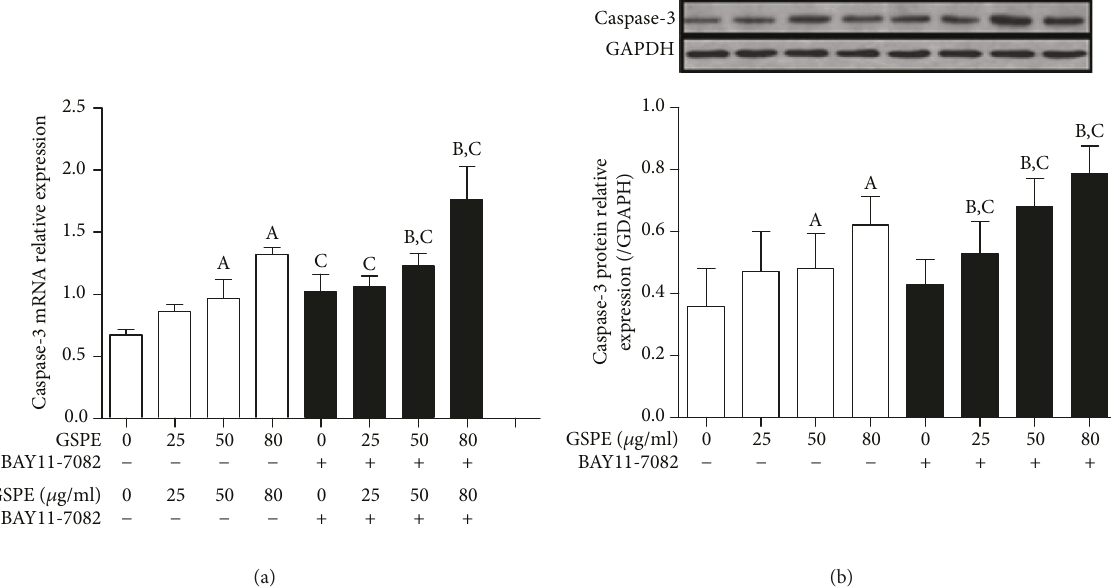
Figure 7: The e ff ects of GSPE and BAY11-7082 on the expression of caspase-3 mRNA and protein in ECA109 cells. (a) GSPE (0 – 80 μ g/mL) and BAY11-7082 (10 μ mol/L) inhibited the expression of caspase-3 mRNA; (b) caspase-3 protein was inhibited by GSPE (0 – 80 μ g/mL) and BAY11-7082 (10 μ mol/L). Each column represents the mean ± SD of three groups of independent samples. A P < 0 05 compared with the 12h group; B P < 0 05 compared with the 24 h group; C P < 0 05 compared with the BAY11-7082 group.